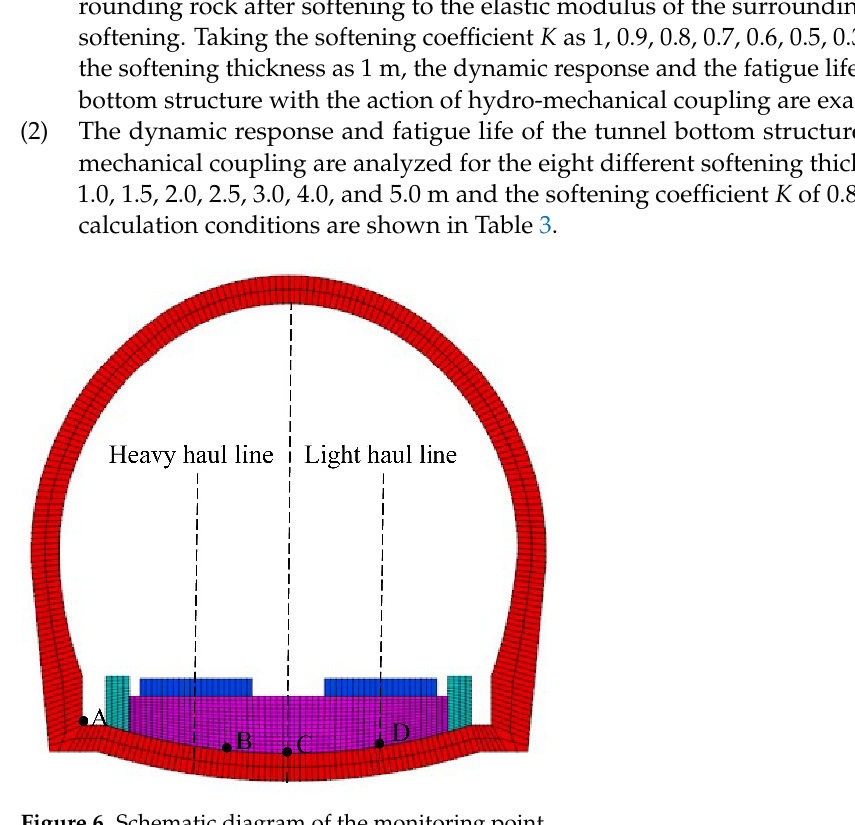
Figure 6. Schematic diagram of the monitoring point. Table 3. Calculation conditions.